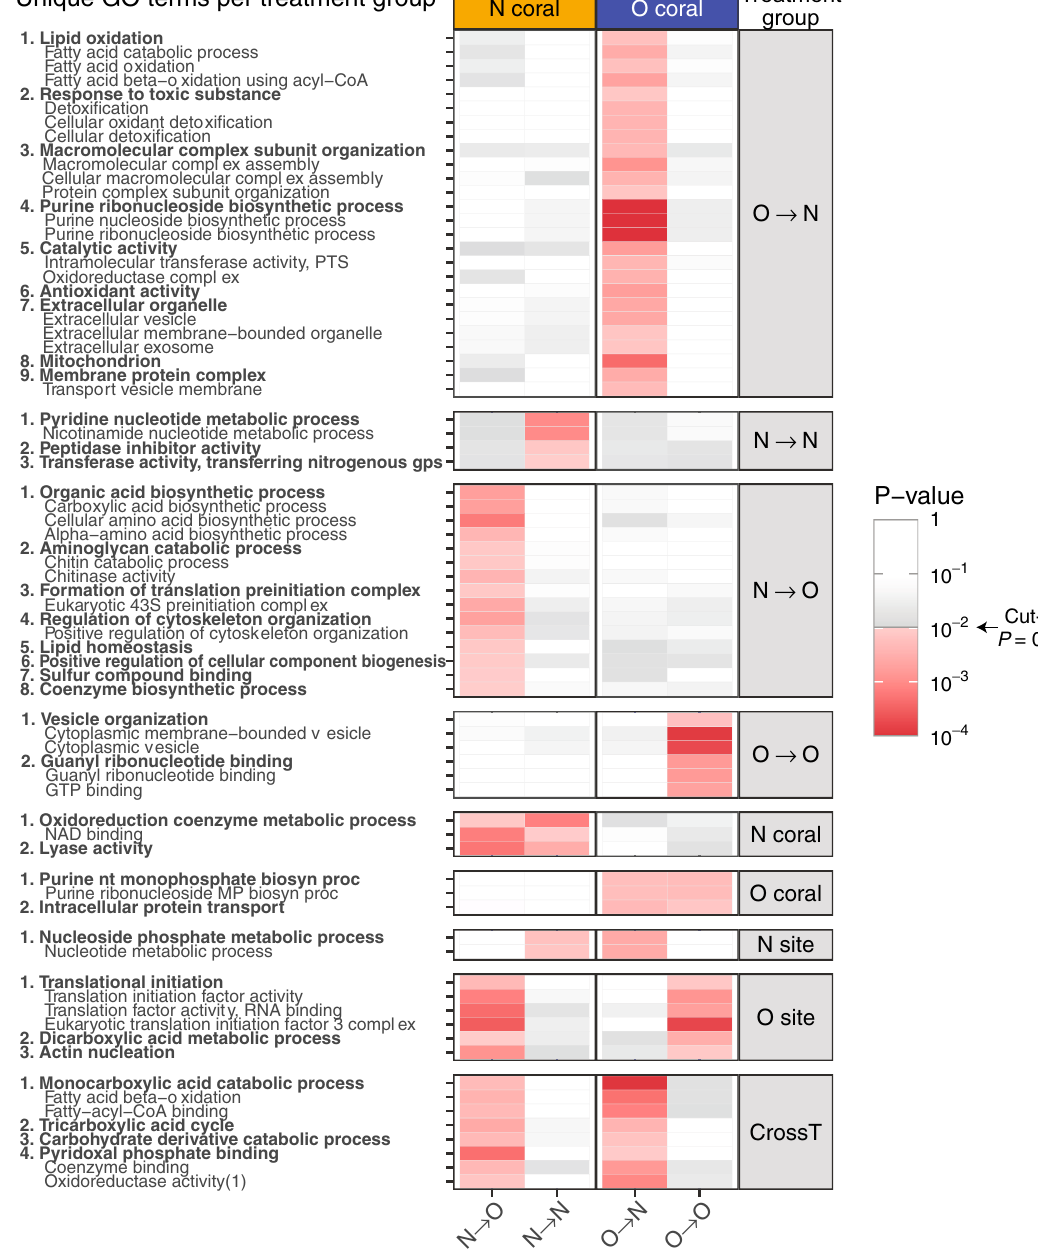
Figure 4. Enriched GO terms uniquely identified to specific treatment groups. Treatment groups are shown in the right column (e.g. N-coral = N-corals at both sites, N-site = N- and O-corals at N-site, CrossT = cross transplantation). The heat-map represents P -values for the associated GO terms. The GO terms are grouped by the parent–child terms with the most parent term in bold (for values, see